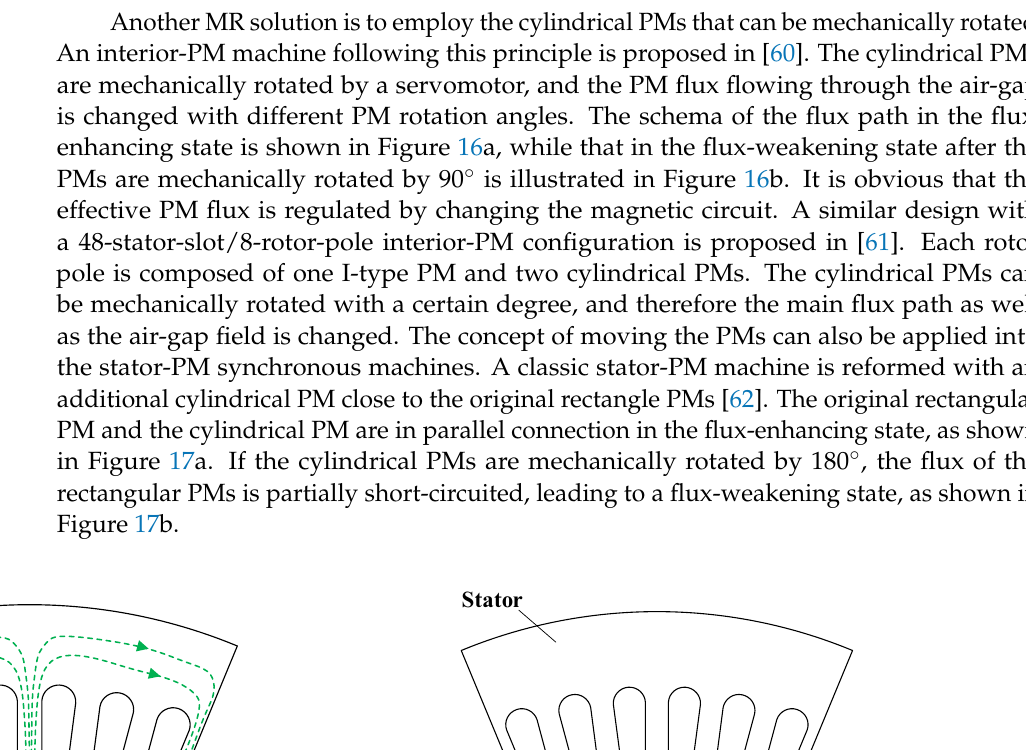
Figure 15. Flux mechanically controllable by shifting PM rotors [8]. ( a ) Flux-enhancing state. ( b ) Flux-weakening state.